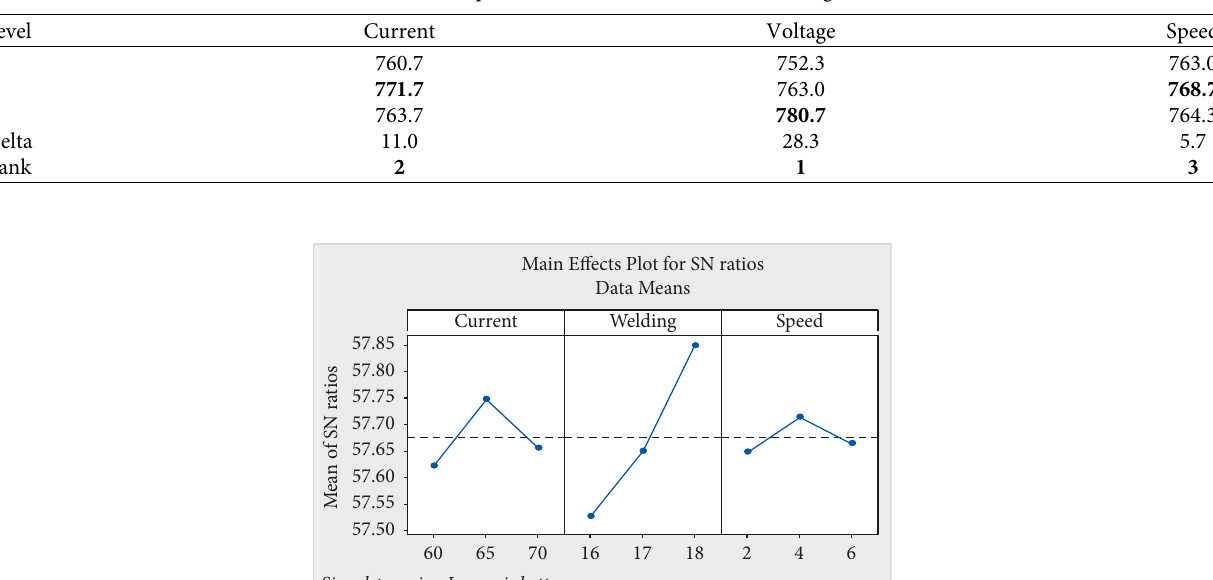
Table 16: Response table for means of tensile strength.